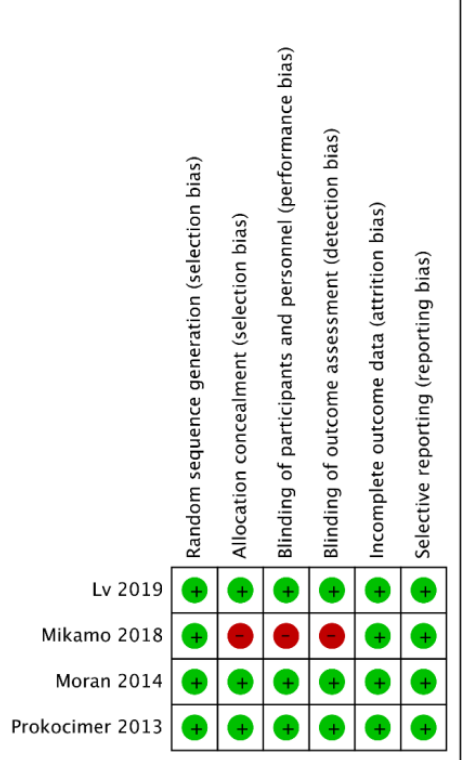
Figure 2. The risk of bias in each domain.